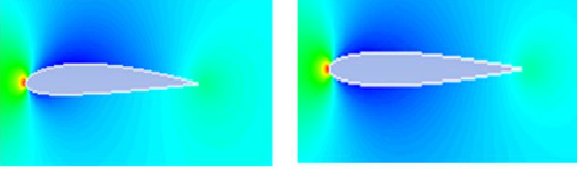
Figure 10. Comparison of pressure variation